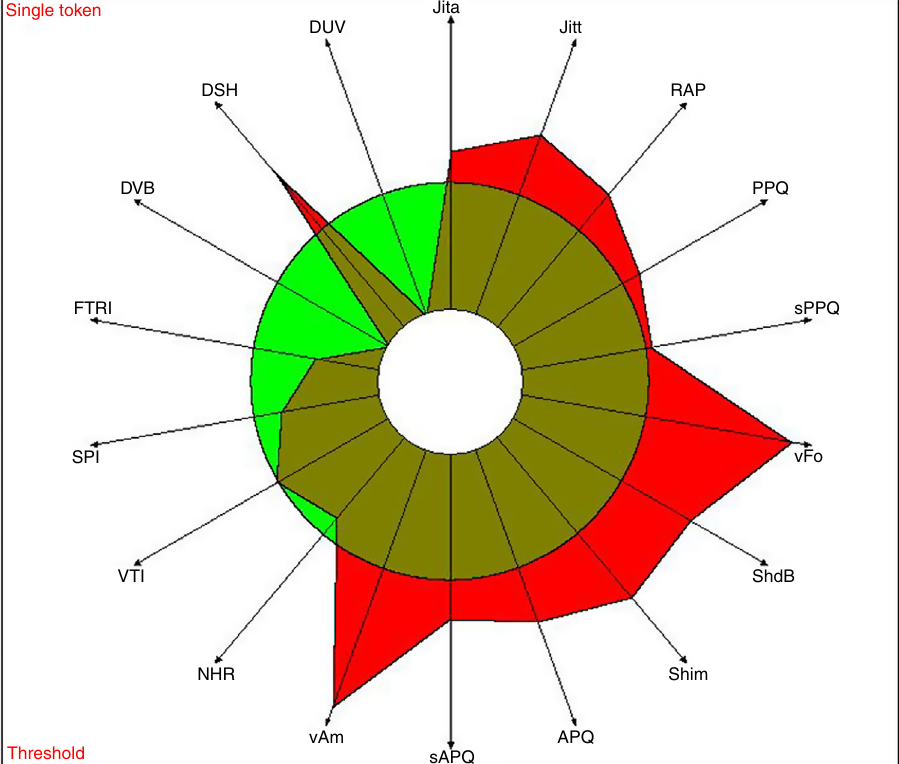
The multidimensional voice program evidences the postoperatory mild worsening of the perturbations in frequency and